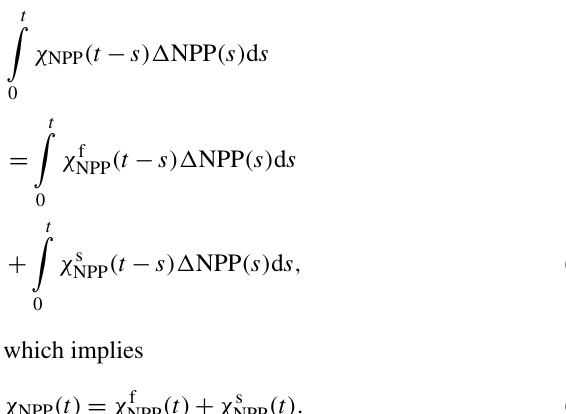
Figure 11. Simplified pool scheme of the land carbon cycle in the MPI-ESM (see Appendix A) with pools split into two groups ac- cording to the characteristic timescales underlying their